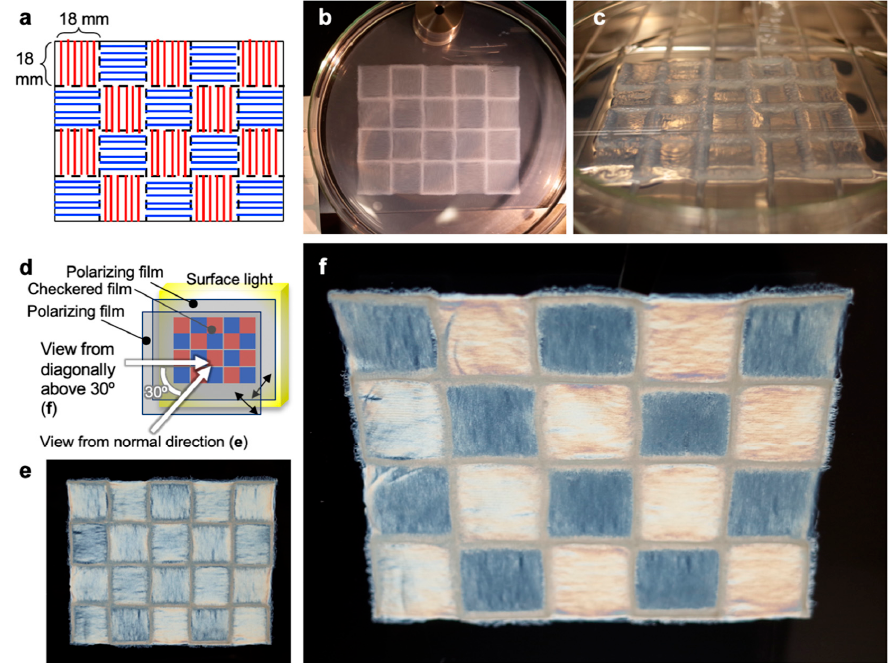
Figure 3. Checkered film of multiaxis oriented nanocellulose. ( a ) Programmed design of the checkered multiaxis oriented nanocellulose film. 10-layer patterned TNW gels in ( b ) an acetone bath from a 1.16 wt% suspension using a 25G needle and discharging and patterning speeds of 3.9 µL/s and 90 mm/s, respectively, and ( c ) dried in a 50 °C oven after removing extra acetone. ( d ) Birefringence observation scheme. Checkered film viewed in the ( e ) normal direction and ( f ) from diagonally above 30° from the normal direction under crossed Nicols.